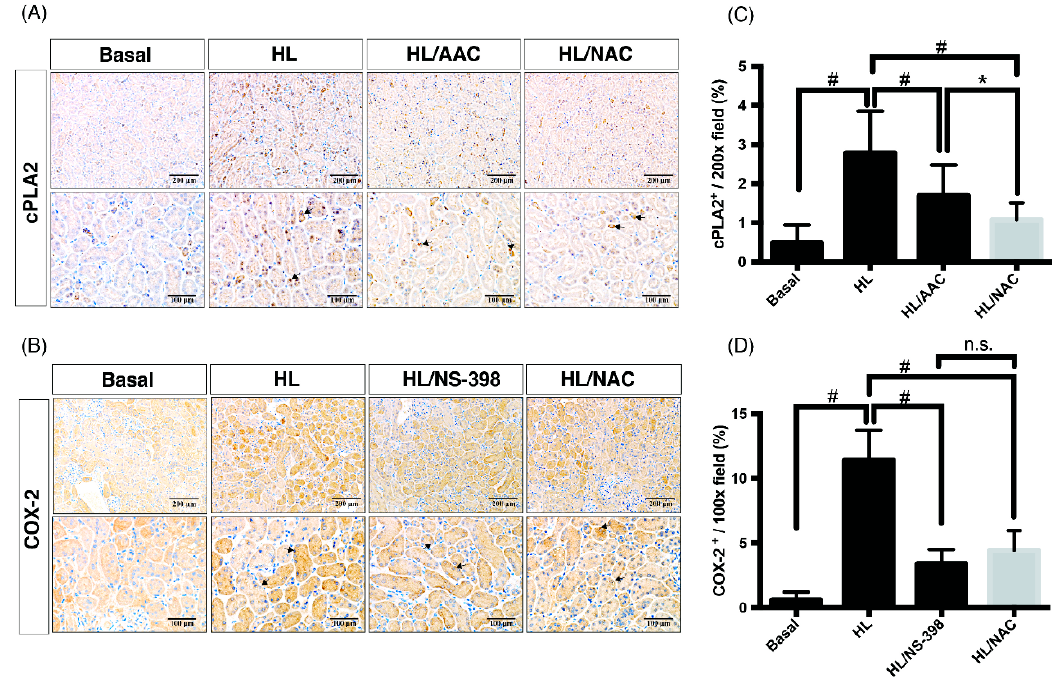
Figure 5. Scavengers of non-specific ROS reduced expression of cPLA2 and COX-2 in obese kidney fibrosis with metabolic endotoxemia. Immunohistochemical staining methods were used to detect expressions of ( A ) cPLA2, and ( B ) COX-2. The HL group (HF mice with ME) exerts the highest expression of cPLA2 and COX-2, which were ameliorated by NAC, AACCOCFS (AAC), and NS-398, respectively. Scale bars in the panels are 200 µ m or 100 µ m. ( C , D ) Quantification analysis indicated that ROS acts as the upstream key signal in the inflammatory cascades of OKF. Quantification analysis as performed by ImageJ software. Data are expressed as mean ± SD ( n = 8); * p < 0.05, # p < 0.01, to compare the differences between the two indicated groups. n.s., not significant.